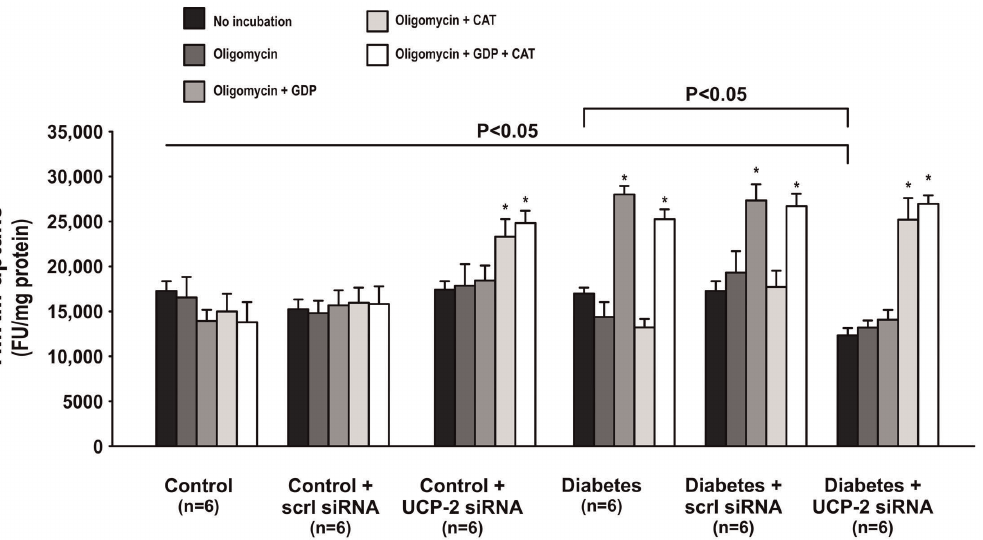
Figure 6. Mitochondria membrane potential measured as TMRM-uptake before and after GDP, CAT or the combination of CAT and GDP during baseline and inhibition of the ATP-synthase in control and diabetic animals with and without scrambled or UCP-2 siRNA. * denotes p , 0.05 vs. no incubation within the group.